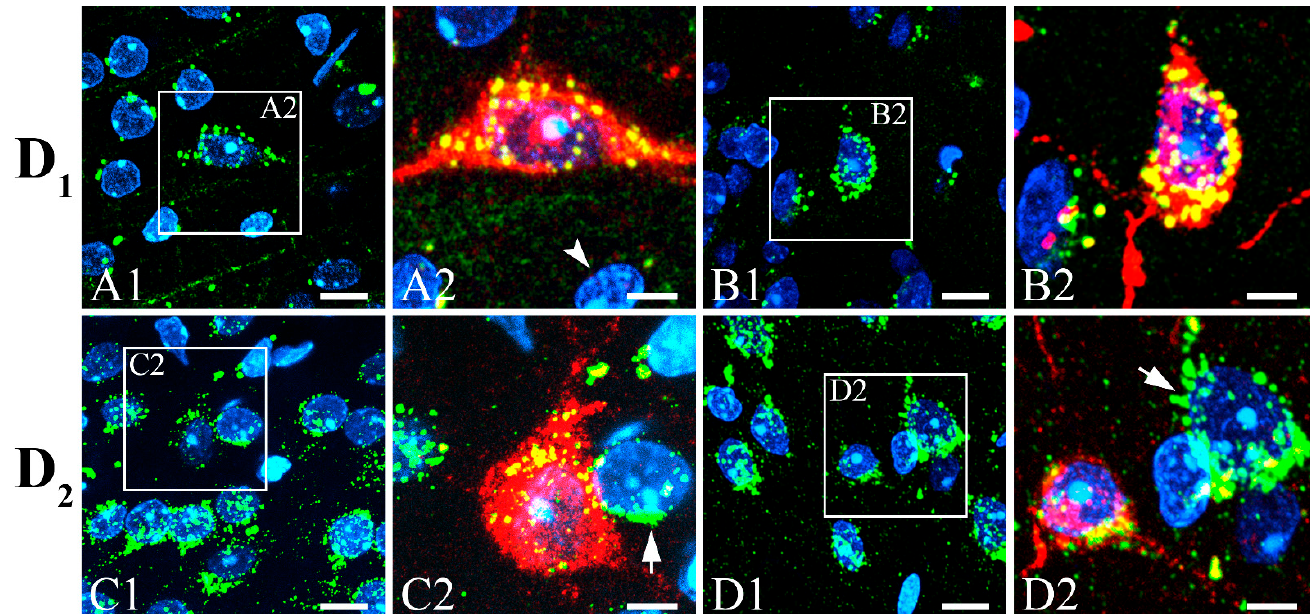
Figure 4. Double-labeling of SST with D 1 or D 2 dopamine receptors in gerbil VC. Fluorescence photomicrographs of immunostained D 1 ( A , B ) and D 2 ( C , D ) dopamine receptors (green) surround some cell nuclei stained with 4 ′ ,6-diamidino-2-phenylindole (DAPI) (blue). ( A2 , B2 , C2 , D2 ) Magnification of white boxes ( A1 , B1 , C1 , D1 ) showing merged images of cells co-expressing both SST (red) and dopamine receptors. SST neurons were clearly surrounded by immunopuncta of D 1 ( A2 , B2 ) and D 2 ( C2 , D2 ) dopamine receptors. There are cells surrounded by dopamine receptors without SST immunoreactivity (arrows). There are also cells that are immunoreactive to neither dopamine receptors nor SST (arrowhead). Scale bar = 10 ( A1 – D1 ) and 5 μ m ( A2 – D2 ). D 1 , D 1 dopamine receptor; D 2 , D 2 dopamine receptor. Table 2. Percentage of SST neurons, and neurons double-labeled with GABA, CBPs, NPY, NOS, or CaMKII in the gerbil